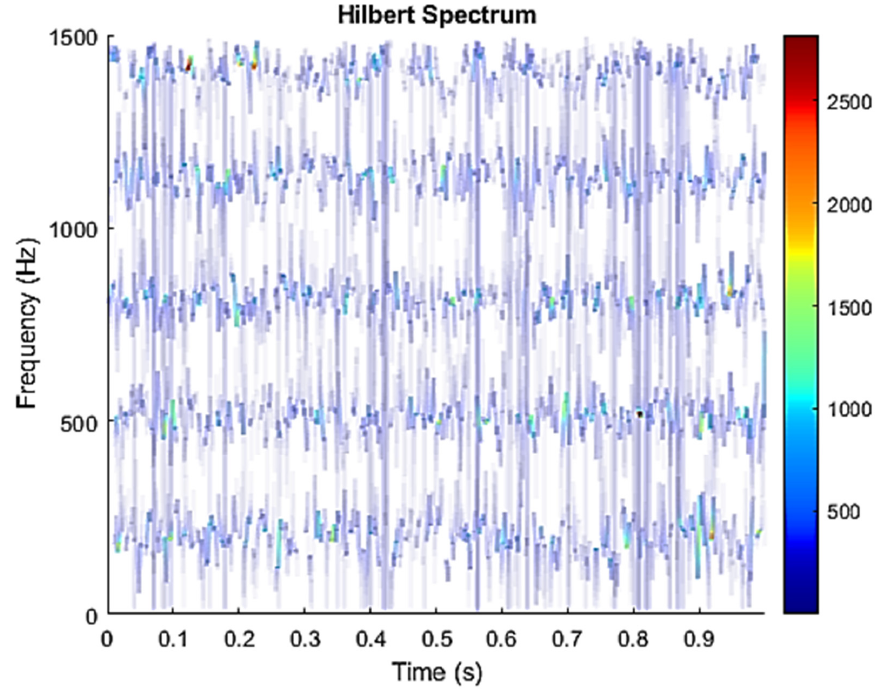
Figure 14. Hilbert Spectrum results of the VMD component obtained from the numerical simulation of the sensor.